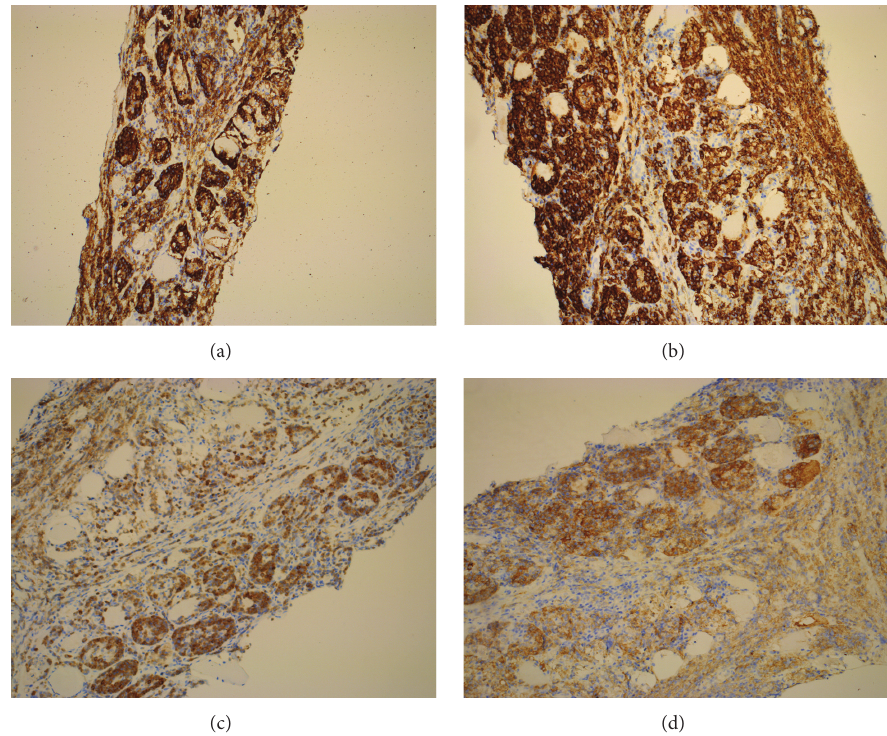
Figure 4: Immunohistochemical findings of the muscle biopsy. (a) Low power view (5x) reveals that CD45 stain highlights the pseudoglandular structures that are also immunoreactive for (b) CD20 (10x), (c) BCL2 (10x), and (d) CD10 (10x).